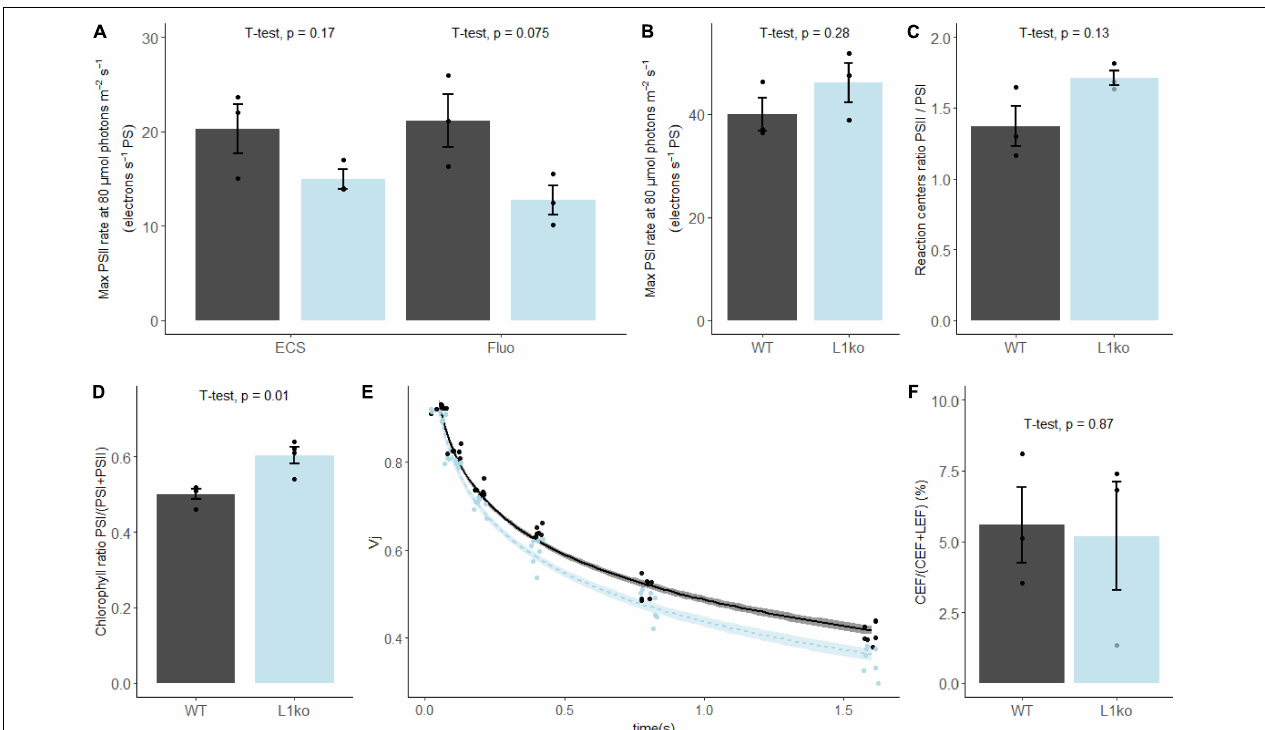
FIGURE 3 | In plants lacking LHCB1, the chlorophyll repartition is shifted toward PSI. (A) The maximal photochemical rate of PSII, measured by electrochromic shift (ECS) and fluorescence (fluo) and (B) PSI measured by ECS. (C) The ratio of PSI/PSII reaction centers measured by a single turnover flash. (D) The average PSI/(PSI + PSII) Chl ratio determined from the 100 ps component of the fluorescence decay measured in fully expanded leaves, excitation wavelength at 633 nm and fluorescence emission at 710–750 nm (see Supplementary Figure 5 ). (E) Fluorescence value measured at 3 ms during a 700 ms saturating pulse normalized over the maximal fluorescence (VJ), upon sequential incubations of the sample with far-red light with increasing time intervals. The points were fitted with a local regression algorithm based on a logarithmic function to visually represent the data distribution in function of the time with a continuous error estimate (black continuous line WT, light blue L1ko). The standard error of the interpolation is shown as a gray area around the curves. (F) Contribution of CEF to the total electron flow in WT and L1ko expressed as a percentage of the electron flow. Individual biological replicates are plotted as points, the histogram shows the average, and the error bars represent the standard error ( n = 3, n = 4 for E ). The averages of the distributions were compared with Student’s t -test, and the p -value of the comparison between WT and L1ko reported above the